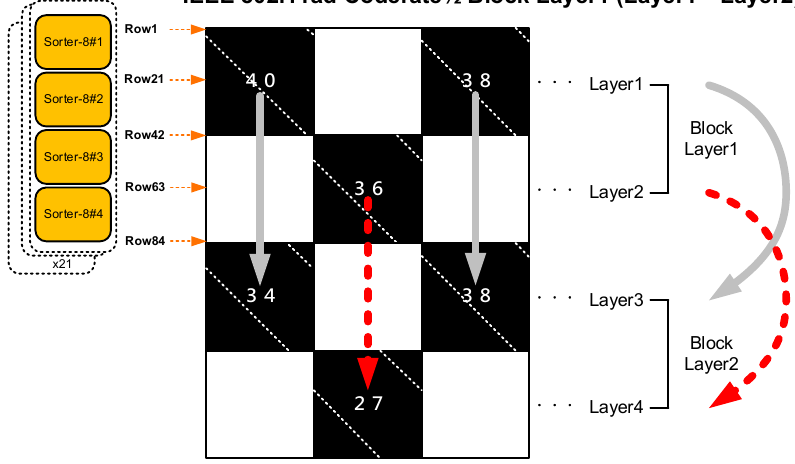
Figure 22. Reconfigurable sorter configuration in IEEE 802.11ad R = 1/2.